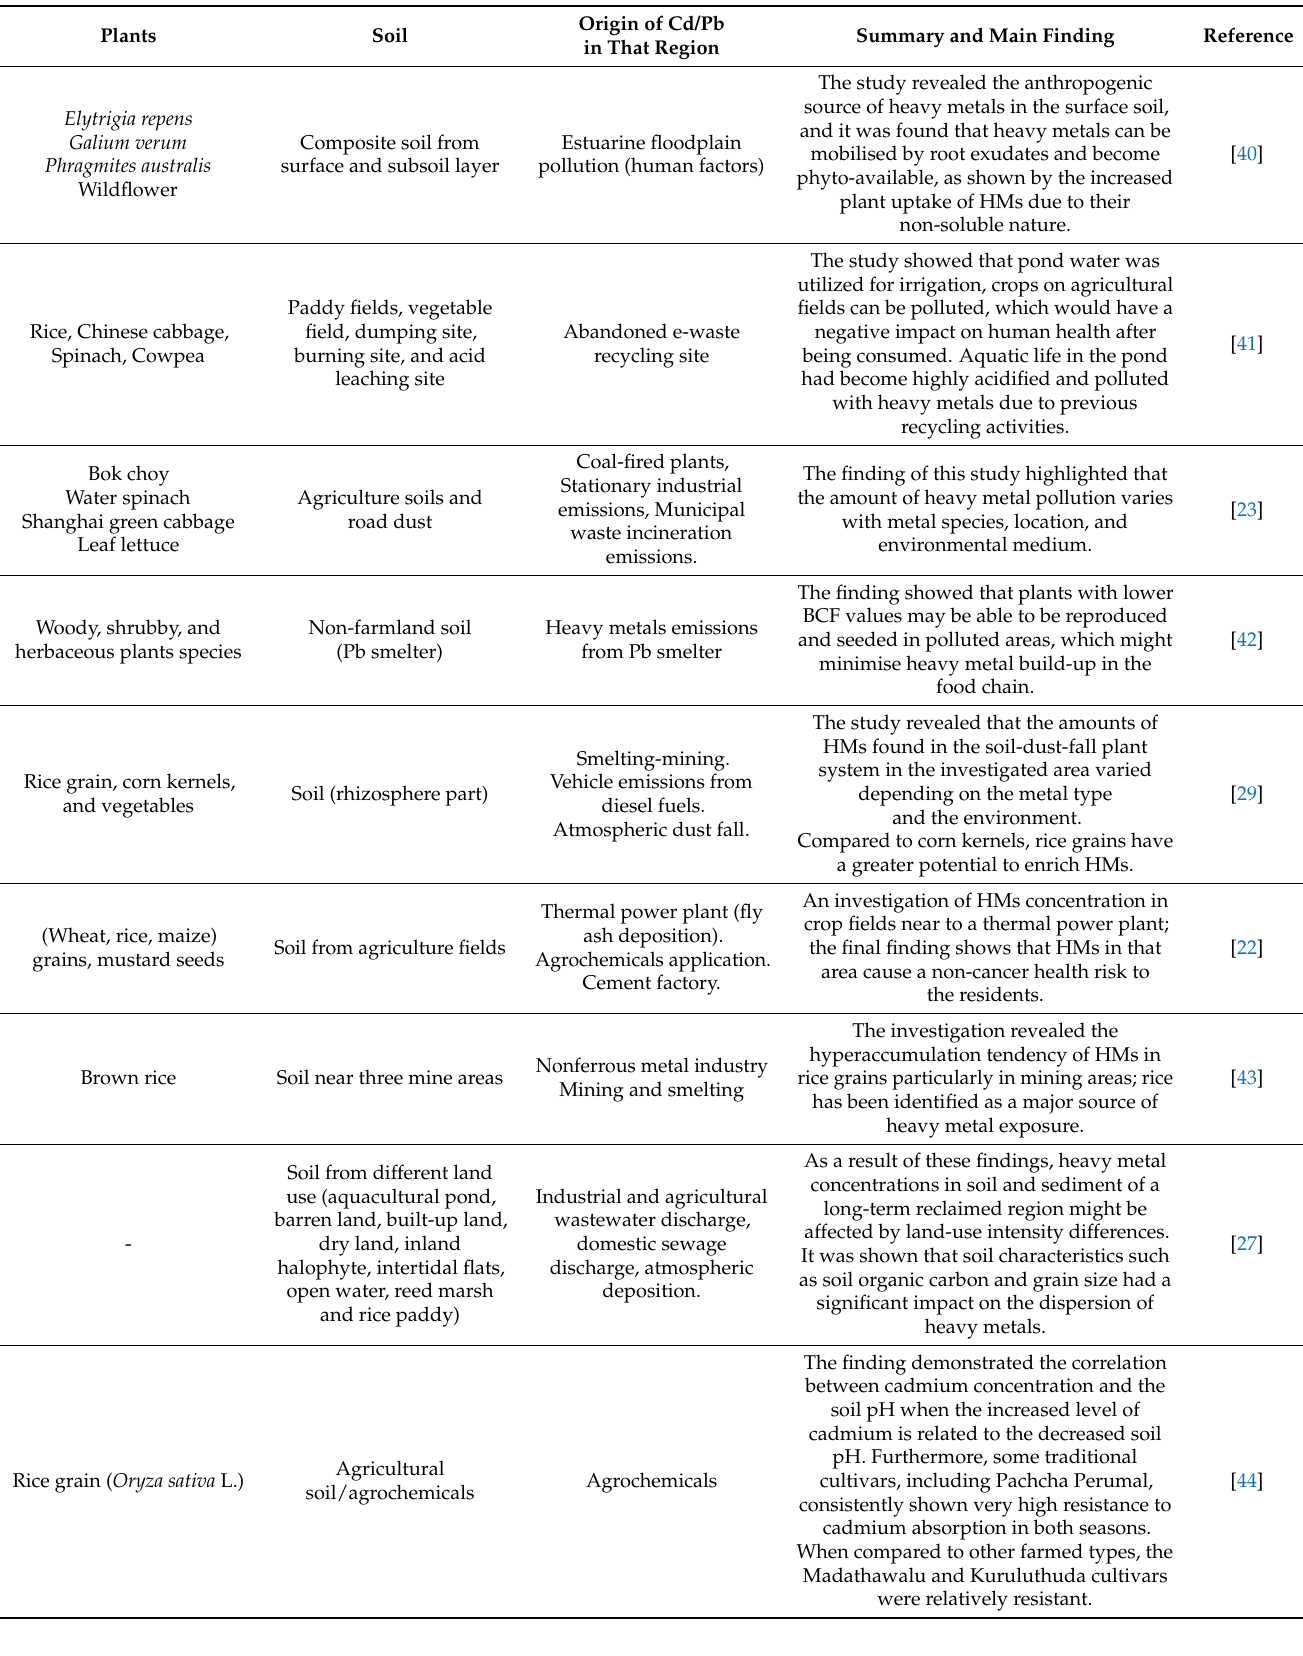
Table 1. Cadmium and lead contamination in soil and plants from a variety of